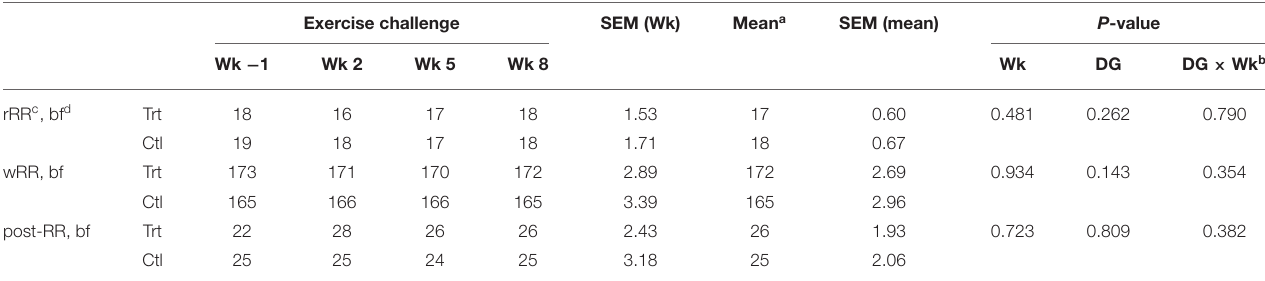
Table 5 ) than Ctl. Concentrations of fecal acetic acid tended to be greater in Trt compared with Ctl ( P = 0.06; Table 5